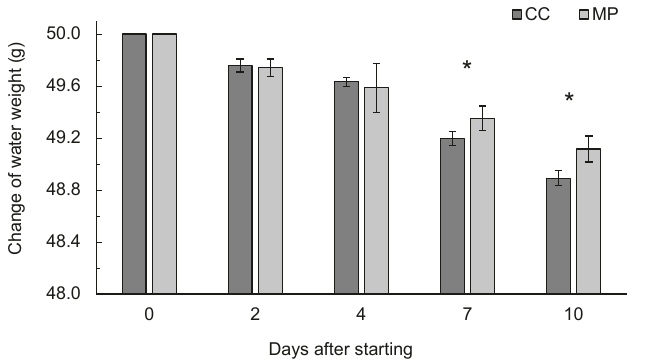
Fig. 3: The change in weight of water inside beakers placed in the gas- tight chambers sealed with conventional corrugated board (CC) and moisture-proof corrugated board (MP) to determine the water va- pour permeability of the storage materials. Error bars indicate stan- dard deviations (n = 5). Asterisks indicate significant differences by Welch’s t -test ( p < 0.05).